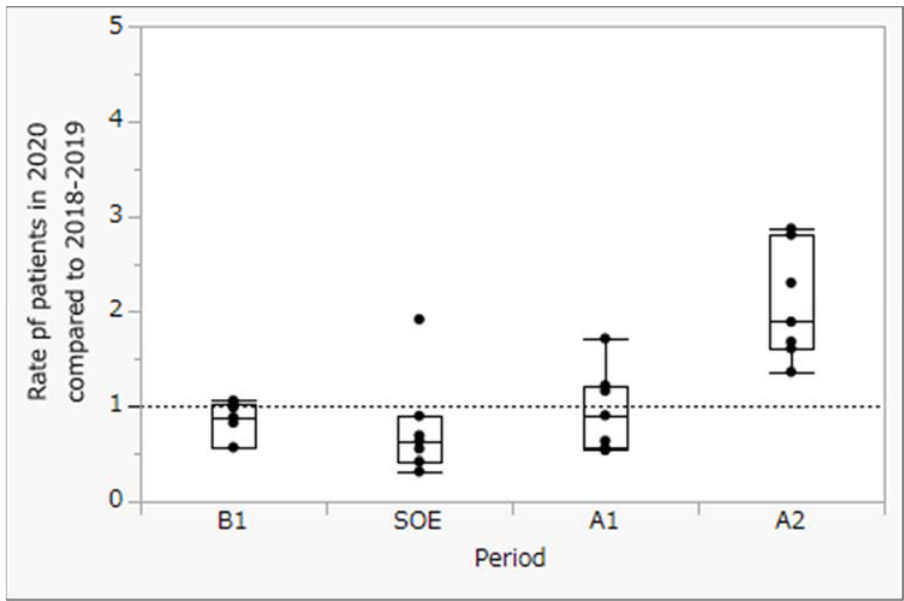
Figure 4. Rate of patients from outside Tokyo in 2020 compared to 2018–2019 at each time period for calendar week. p < 0.05 (Tukey’s honestly significant difference test).